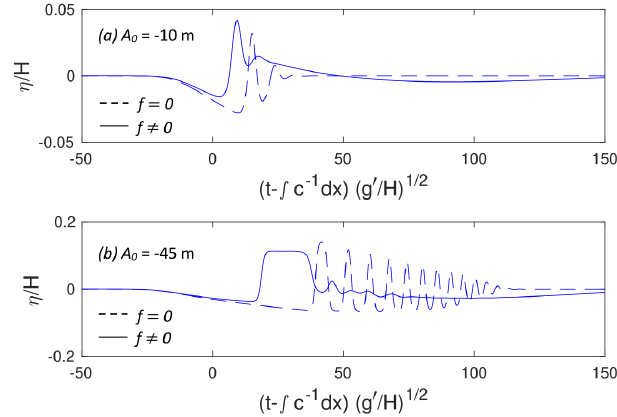
Figure 9. η/H at x/L = 1 . 5 for the parameters of Fig. 8. (a) A 0 = − 10m and (b) A = − 45m. The solid (dashed) lines are with 0 (without)